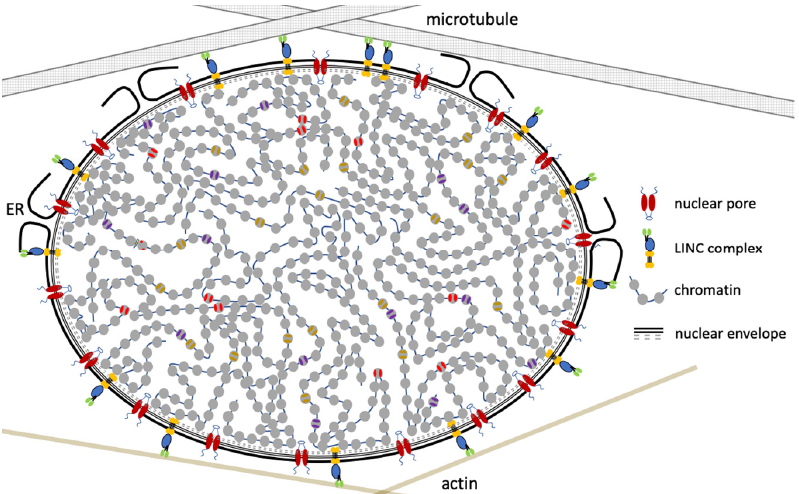
Figure 1. The nucleus is an integral part of the cell’s cytoplasm. The cytoskeleton interacts with chromatin through the linker of nucleoskeleton and cytoskeleton (LINC) complex, allowing mechanotransduction of signals from outside the cell to swiftly and directly impact chromatin structure and gene expression.